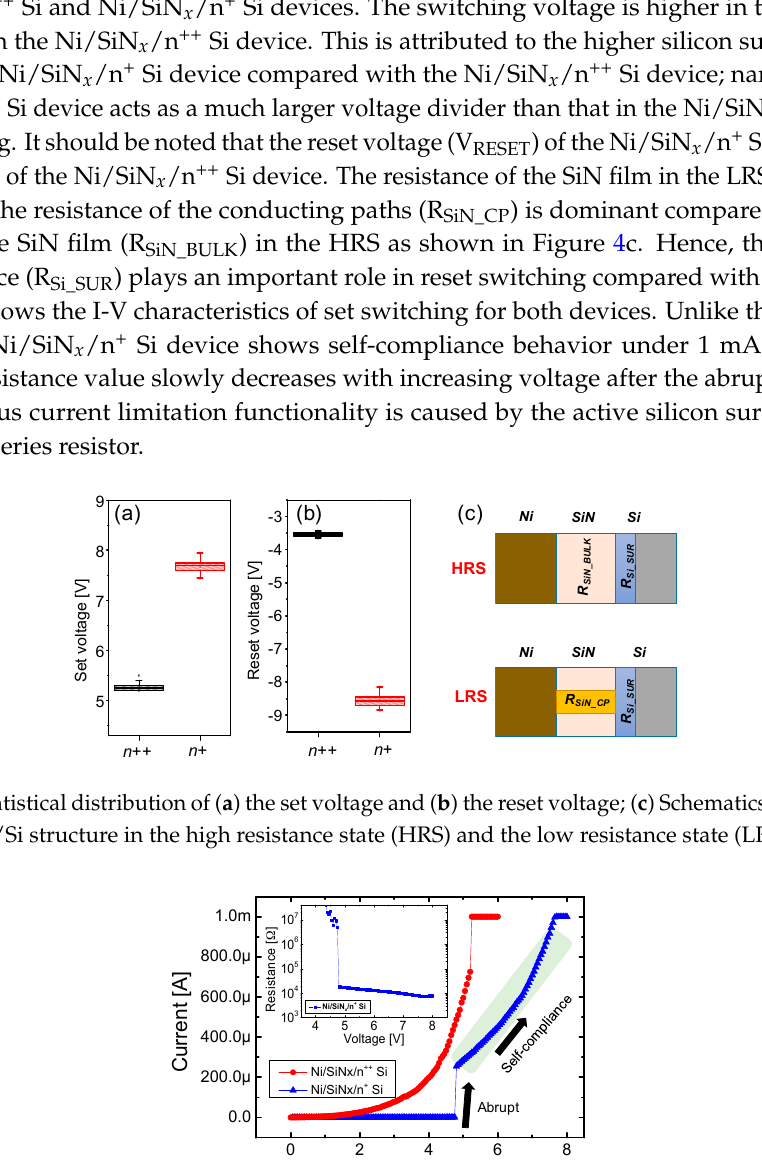
Figure 3. DC I-V bipolar resistive characteristics of the Ni/SiN x /n + Si RRAM device.